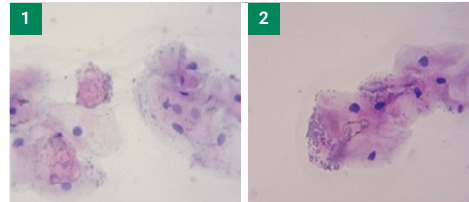
Figure 3. Blade smear with hyphae(1) and